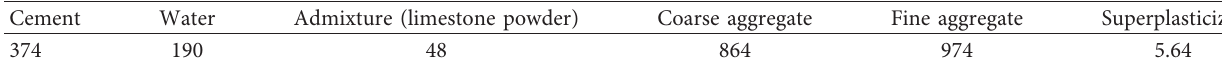
Table 2: Concrete mix proportion scheme (kg/m3).